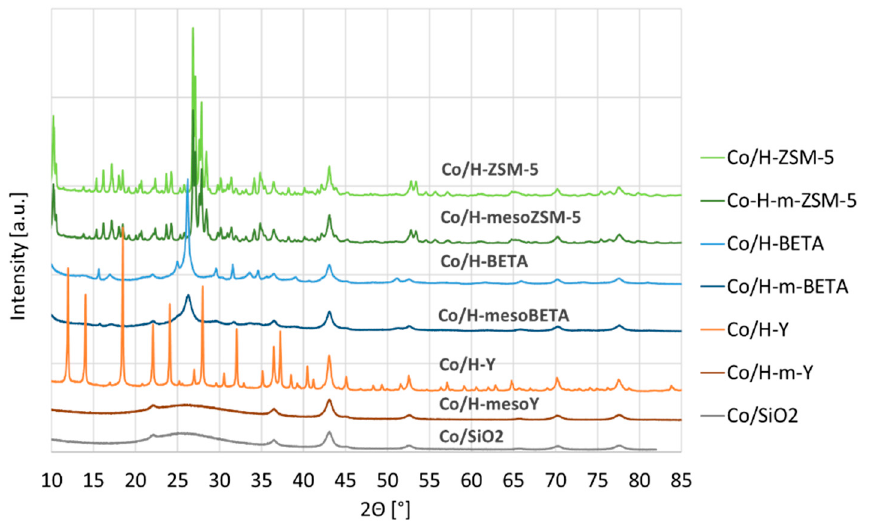
Figure 2. XRD patterns of the supported Co catalysts.